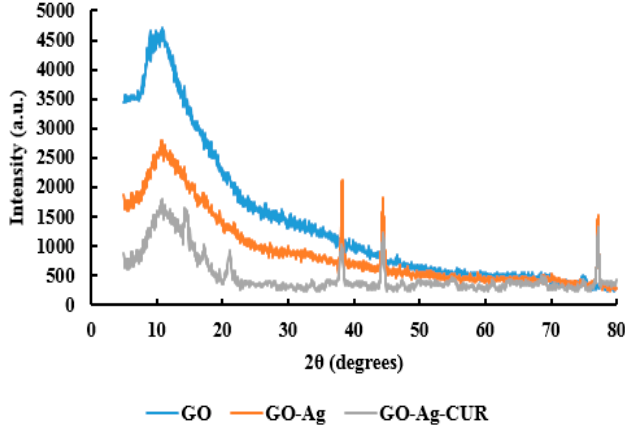
Figure 2. The XRD patterns of GO, GO-Ag, and GO-Ag-CUR.